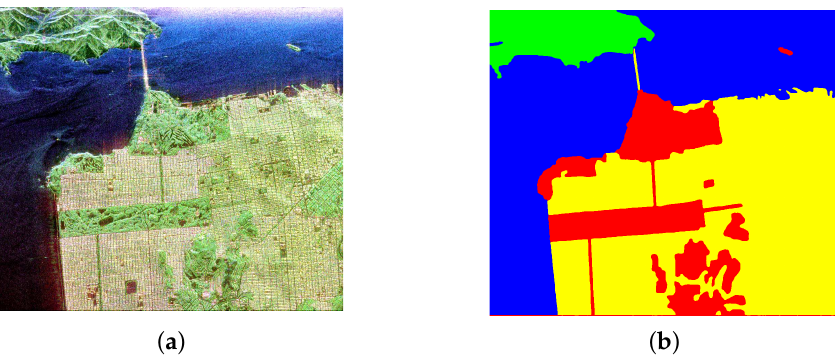
Figure 4. The San Francisco dataset. ( a ) Pauli RGB composite image. ( b ) Ground truth map. Flevoland-1991 was obtained from the Flevoland test site in 1991 and contains a variety of crops and artificial targets, and the pseudo-RGB image synthesized by its L,P,C- band SPANs is shown in Figure 5a. The ground truth was inherited from Hoekman [29] and CRPM-Net [30] shown in Figure 5b. In the ground truth map, the black pixels are those that were not involved in the experiment.